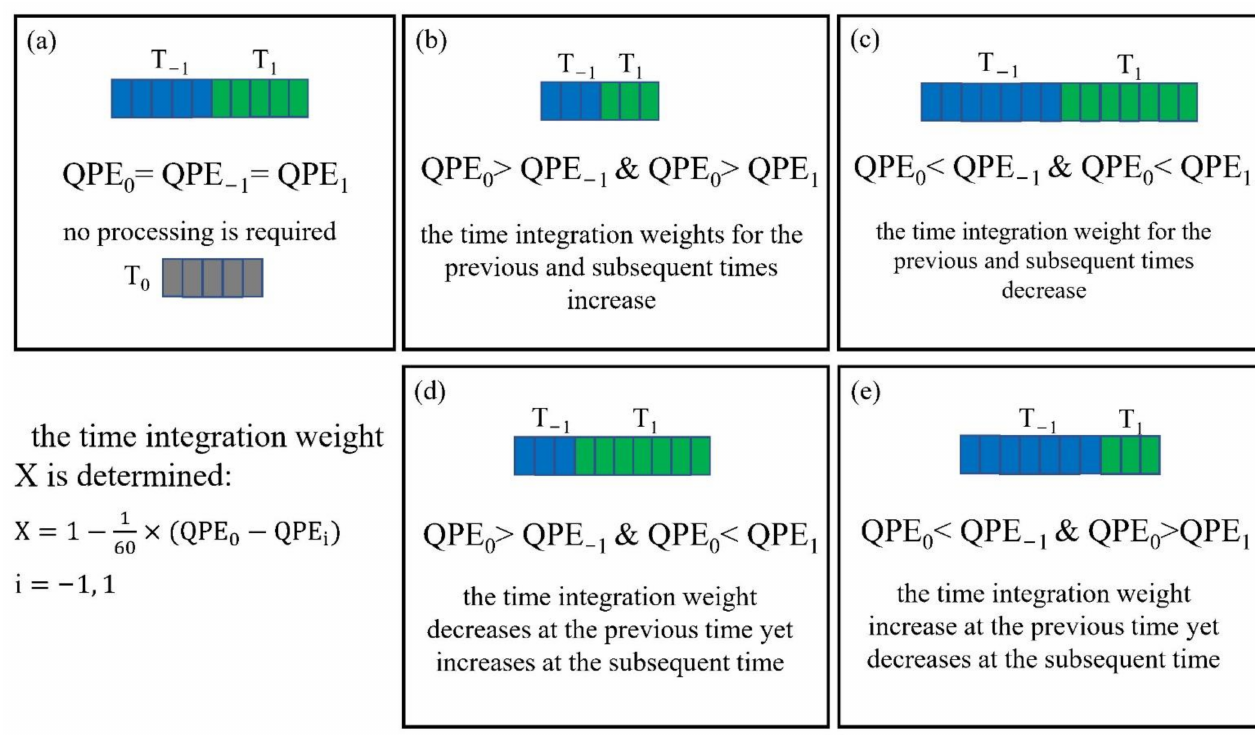
Figure 6. Dynamic time integration method ( a ) the ideal state, ( b ) both smaller than, ( c ) both greater than ( d ) front smaller than rear greater than, and ( e ) front greater than rear smaller than and dynamic time integration coefficient (the number of bars represents QPE, blue and green bars represent QPE -1 and QPE 1 , respectively, assuming that the five grey bars represent QPE 0 and remain